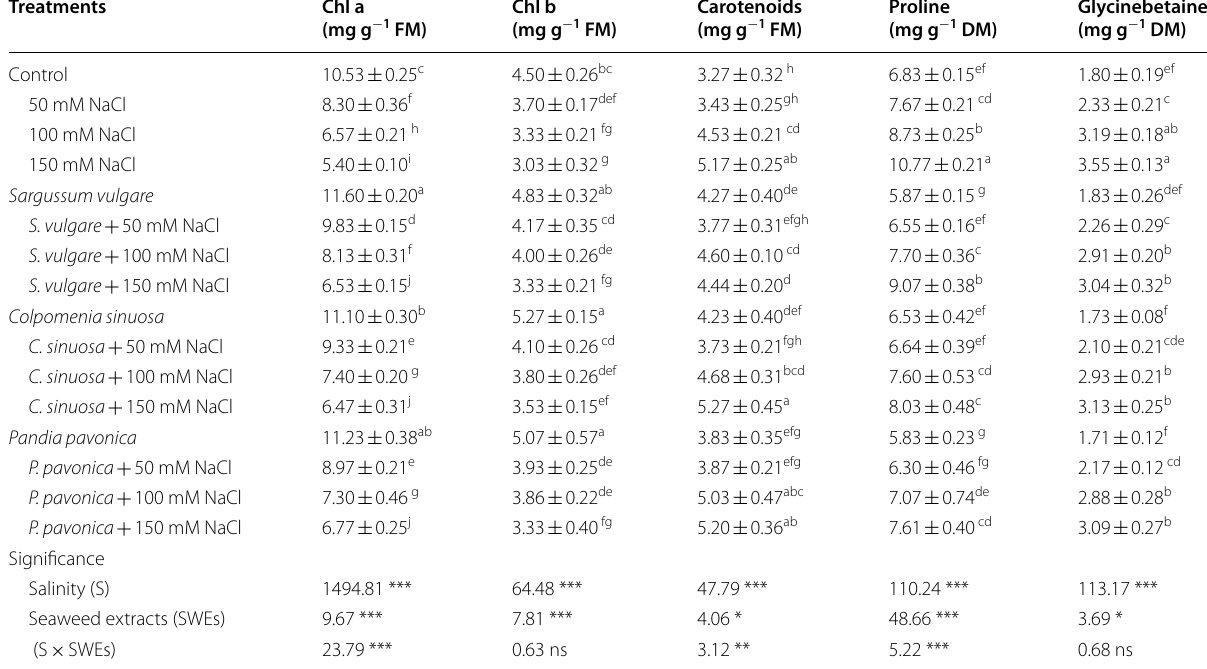
Table 3 Physiological traits (Chl a, Chl b, carotenoids, proline, and glycinebetaine) of 21‑day‑old pea seedlings treated with NaCl and SWEs ( S. vulgare , C. sinuosa , and P. pavonica ) single and combined treatments. The values shown are average of three replicates standard ±